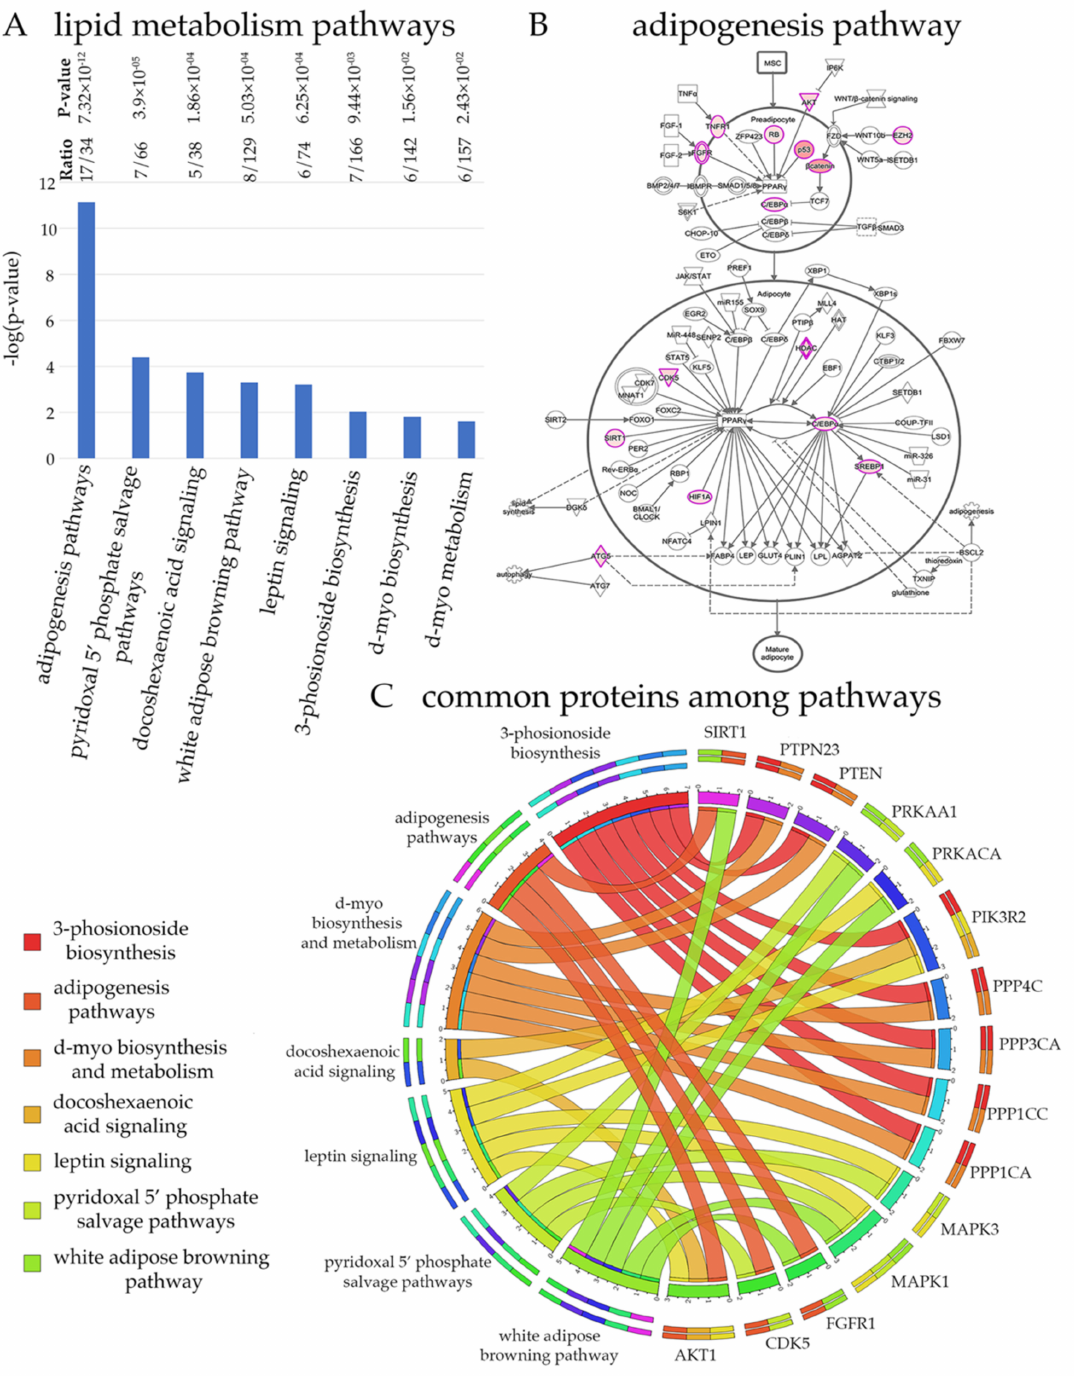
Figure 3. Maintaining lipid homeostasis is an important task for UMNs. ( A ) List of canonical pathways that are represented by HSP/PLS proteins. ( B ) Schematic drawing of adipogenesis pathway. Proteins with more than 3 binding partners are marked pink and proteins with more binding partners are depicted with increasing color intensity. ( C ) Circular representation of proteins commonly present among different canonical pathways related to lipid